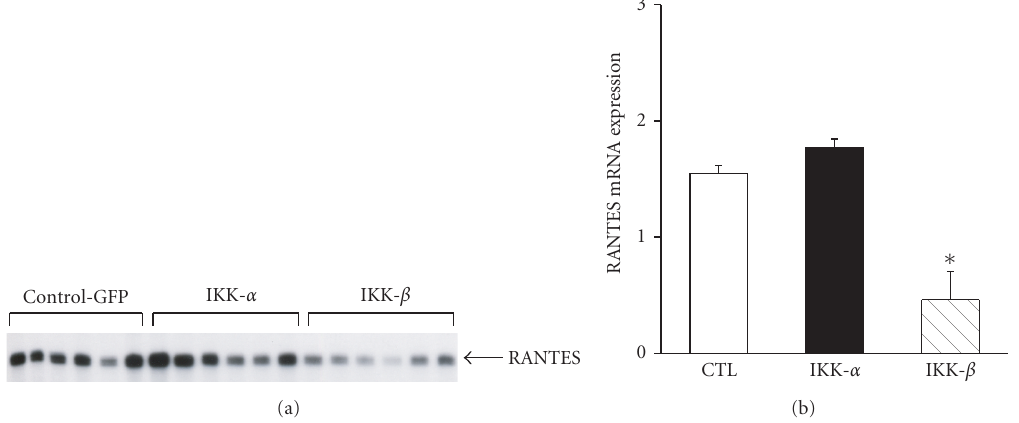
Figure 6: E ff ects of dominant negative inhibition of the NF- κ B pathway on LPS-induced RANTES gene expression. (a) Ribonuclease protection assay showing the e ff ects of transfecting expression plasmids encoding dominant negative constructs for IKK α and IKK β , on RANTES expression by C2C12 myotubes exposed to LPS. Control cells were transfected in an identical fashion with a control plasmid (CTL- GFP) to determine transfection e ffi ciency. (b) Quantification of RANTES mRNA levels in LPS-stimulated myotubes previously transfected with IKK α or IKK β dominant negative mutant constructs. All data are normalized to the L32 housekeeping gene. ∗ P < . 05 for comparisons to the CTL-GFP